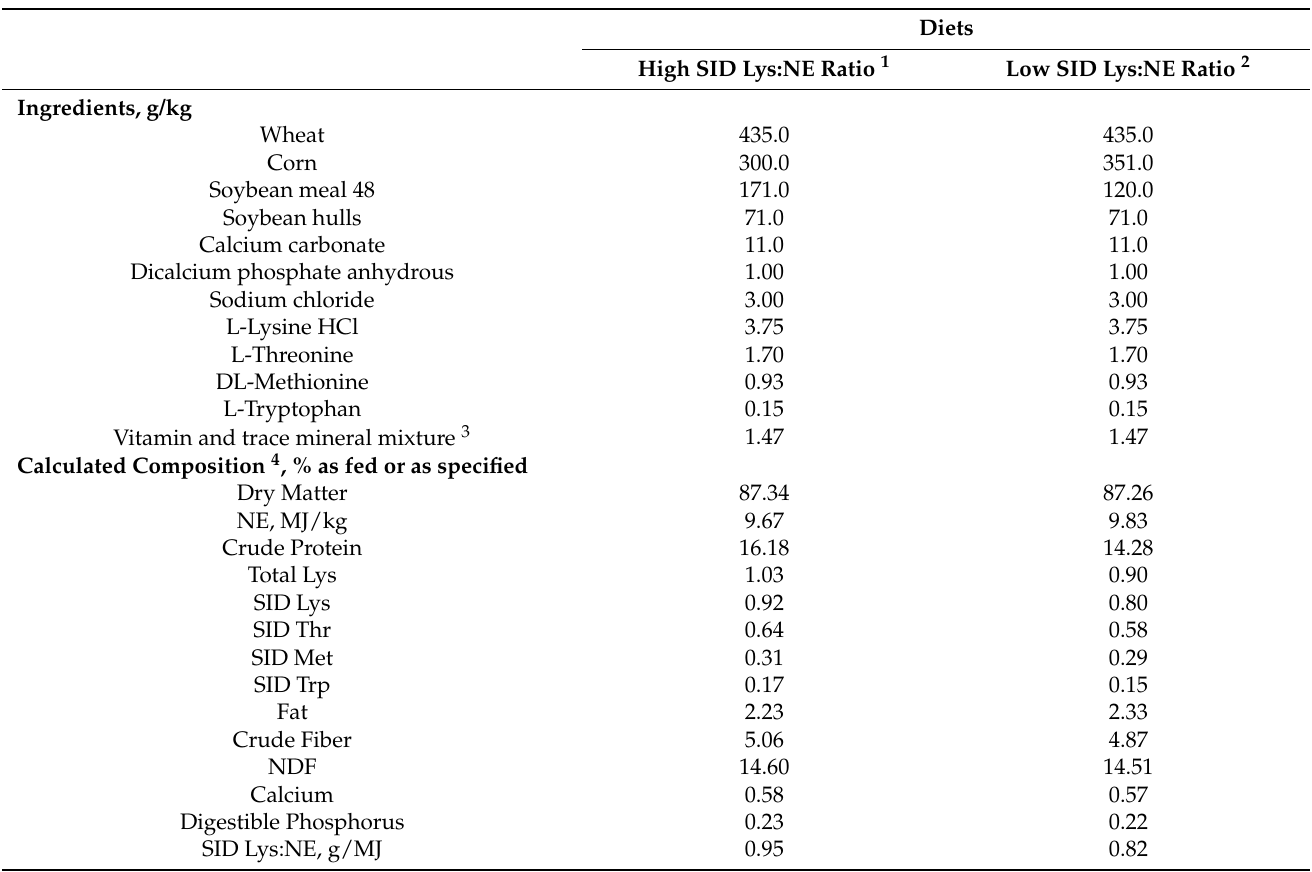
Table 1. Composition on an as-fed basis of the experimental diets.